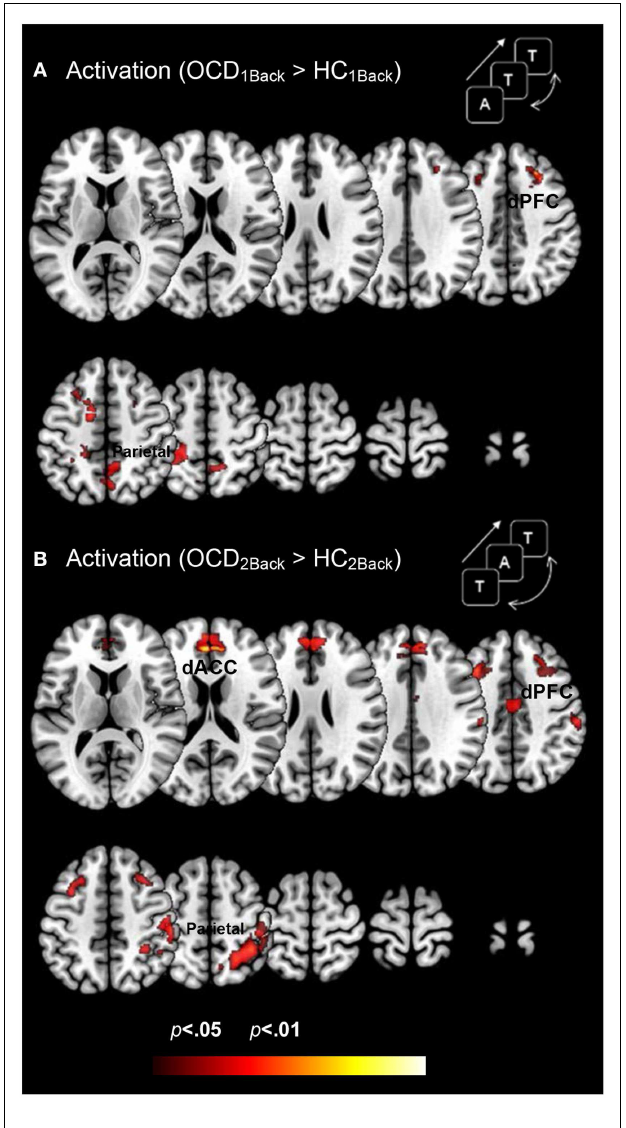
FIGURE 3 | Dysfunctional activation profiles in OCD (relative to controls) are depicted for both (A) the 1Back level of memory and (B) the 2Back level of memory load . Increased activation in OCD ( p < 0.05, cluster level) is depicted on identical ascending mosaics of axial views.These activation profiles indicate increased activation in dorsolateral prefrontal cortex (dPFC), the dorsal anterior cingulate (dACC), and the parietal cortex in OCD. Notably the degree of dysfunctional activation in OCD scales as a function of memory load.We speculate that the parametric demands as expressed in dysfunctional activation profiles load disproportionately in OCD participants. As will be seen, brain network profiles in OCD do not strictly follow activation patterns, evidence that signatures of network interactions may complement psychopathology revealed in activation